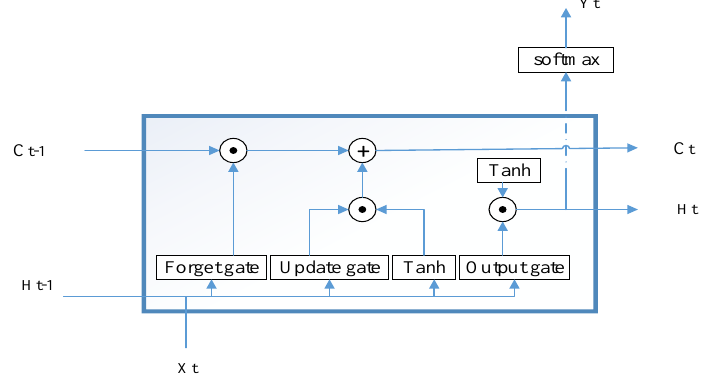
Figure 2. Long short-term memory (LSTM) hidden layer structure.